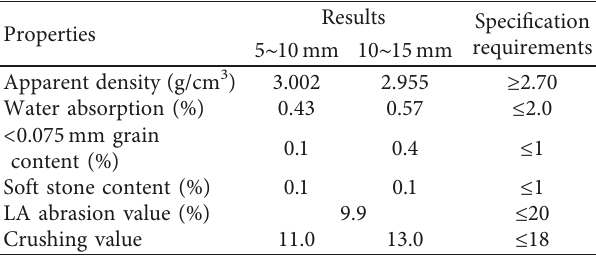
Table 2: Properties of the coarse aggregates.